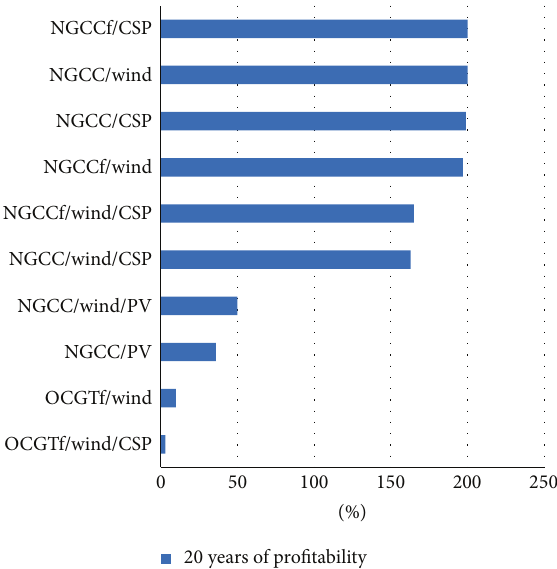
Figure 6: Unit costs of production under energy source combina- tions (C/MWh).